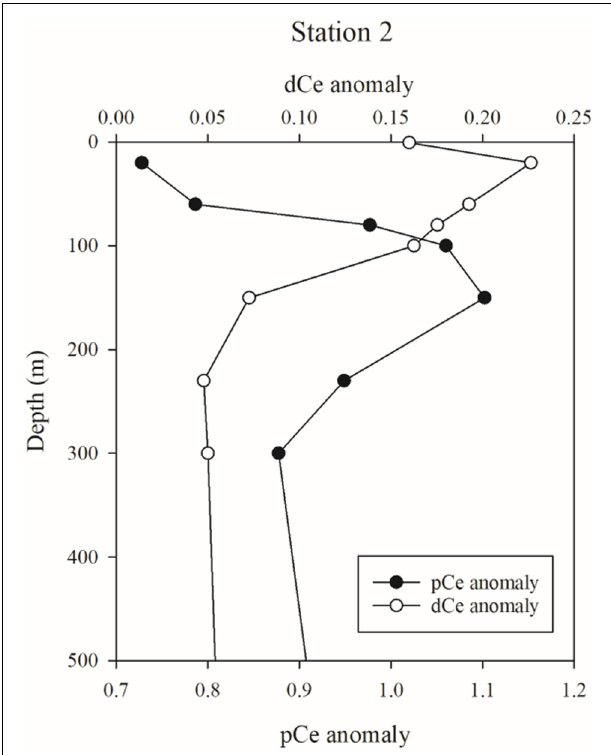
FIGURE 11 | Dissolved (dCe) and particulate Ce (pCe) anomalies at station 2, showing the vertical offsets and differing scales between the two